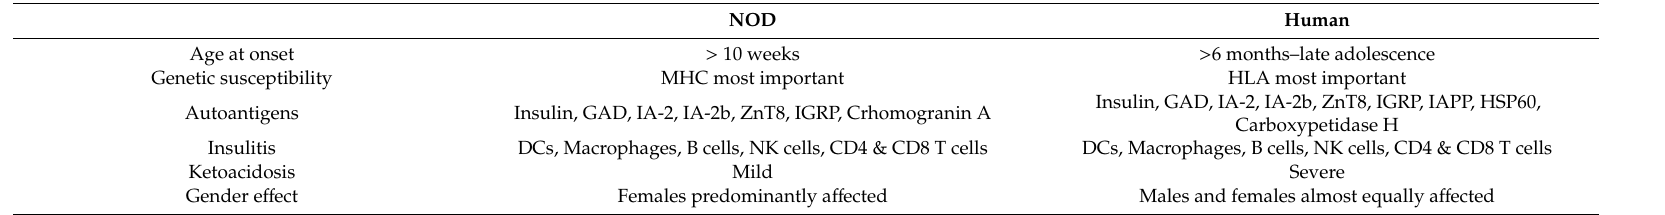
Table 1. Autoimmune diabetes developed by NOD mouse compared to human